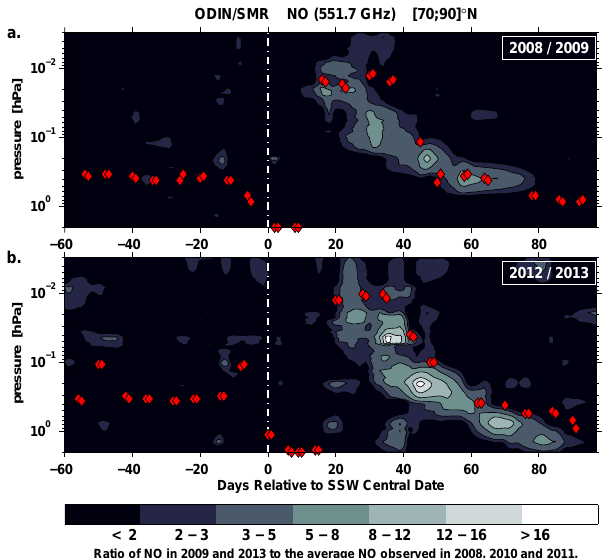
Figure 3. Relative NO enhancements: ratio of nitric oxide in 2008/2009 and 2012/2013 to the average NO measured at the corre- sponding latitude, pressure and time in 2007/2008, 2009/2010 and 2010/2011. Time is expressed in days relative to the central date of each SSW event (white dash-dotted lines) to make the compar- ison easier. Red diamonds indicate the height of the stratopause as inferred from SMR temperature